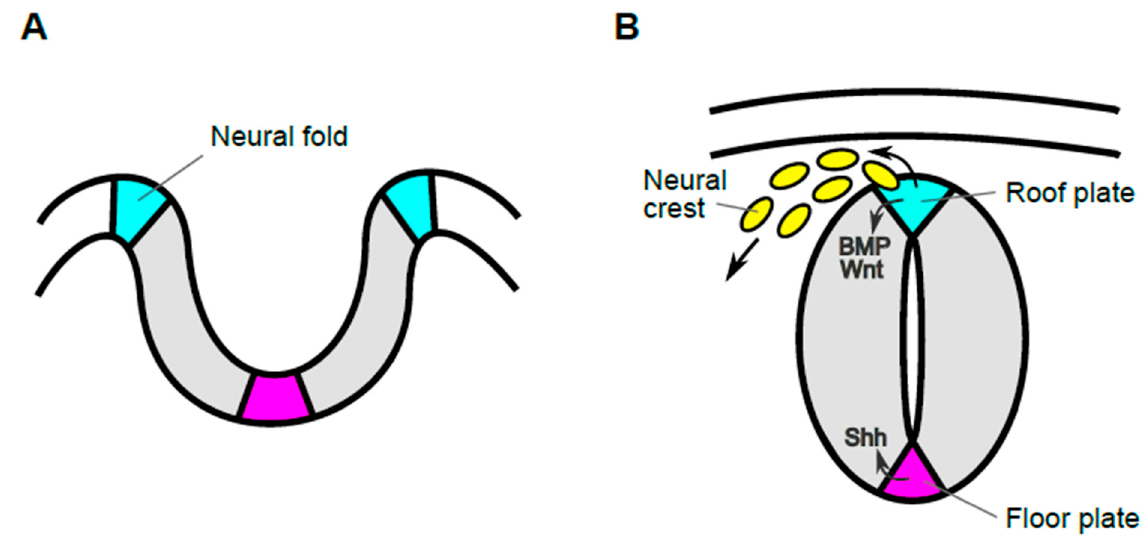
Figure 1. Transition in morphology of neural tissue and functions of cells in the most dorsal region during early develop- mental stages. Schematic images of transverse sections of developing spinal cord before ( A ) and after ( B ) closure of the neural tube during mouse development. The edge of the neural plate elevates and becomes the neural fold (cyan), from which neural crest cells are generated ( A ). Then, the lateral tips of the neural fold fuse, generating the neural tube ( B ). Cells in the most dorsal region of the neural tube, or roof plate (cyan), act as progenitors of migrating neural crest cells (yellow) and also as the organizing center for dorsal neuroepithelial cells. Roof plate cells secrete signaling molecules such as Wnt and BMP, which govern development of both neural crest and dorsal neuroepithelial cells. By contrast, cells in the most ventral region, the floor plate (magenta), act as the ventral organizer, by producing Shh.